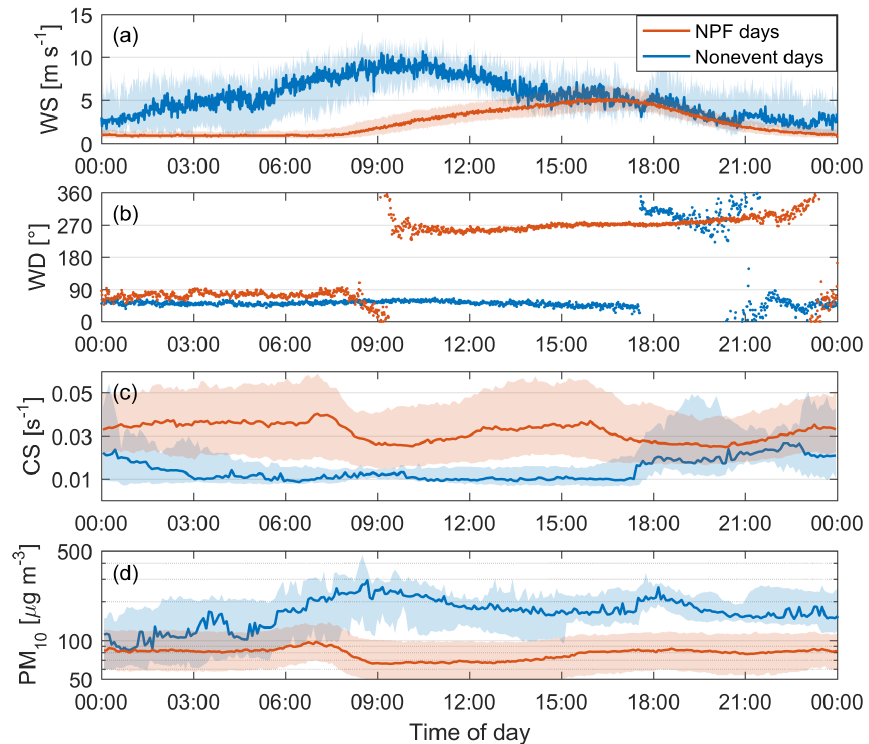
Figure 5. Diurnal variation of (a) wind speed, (b) wind direction, (c) condensation sink, and (d) mass of particles smaller than 10µm in Hada Al Sham during NPF days (red lines) and nonevent days (blue lines). The solid lines show the median values and the shaded areas represent the 25th–75th percentile